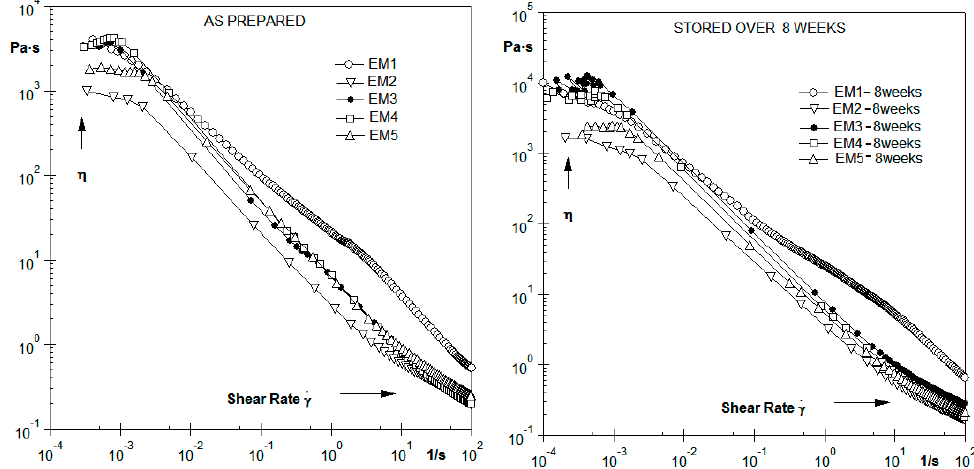
Figure 5. Viscosity curves recorded for the as-prepared and stored emulsions with different amounts of polar fraction in interesterified fat (the content of polar fraction has been given in Table 1). Error bars of the measured values are depicted with the markers size.